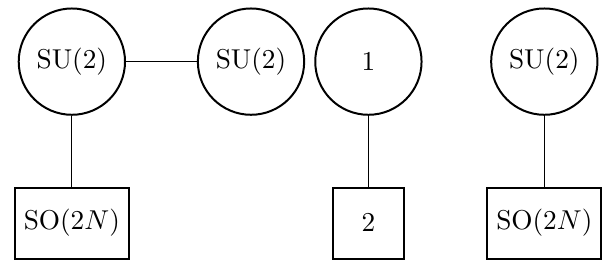
Figure 1 . The quiver on the left-hand side is a bad theory. We claim that the quiver on the right-hand side | constituted of two decoupled quivers | is a good realization of the bad theory on the left.